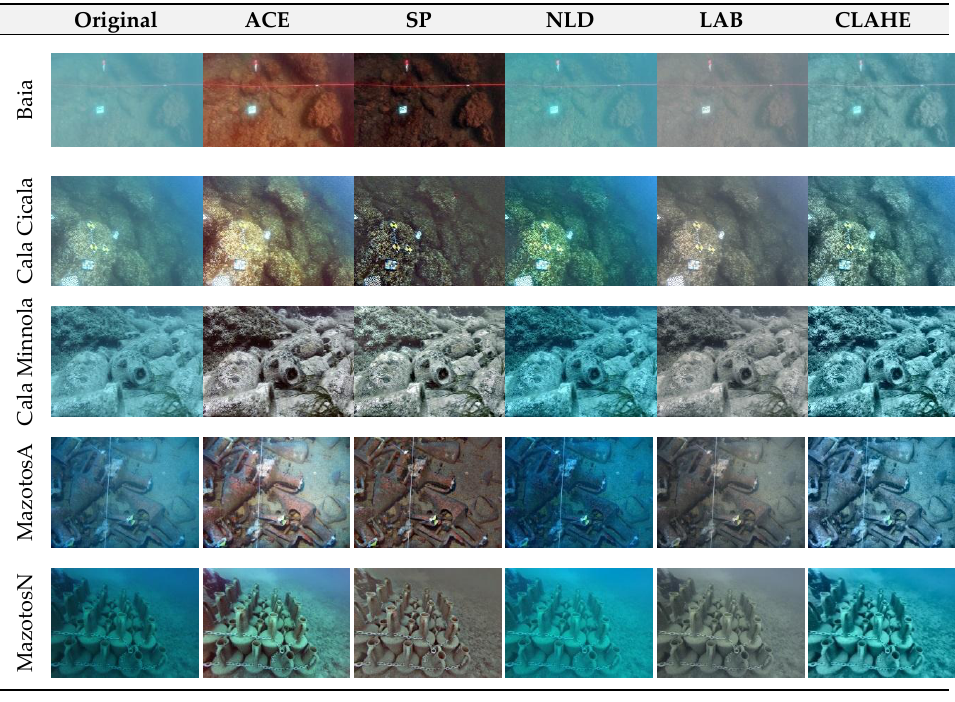
Figure 5. Examples of original and corrected images of the 5 different datasets. Credits: MiBACT-ISCR (Baiae images); Soprintendenza Belle Arti e Paesaggio per le province di CS, CZ, KR and University of Calabria (Cala Cicala images); Soprintendenza del Mare and University of Calabria (Cala Minnola images); MARELab, University of Cyprus (MazotosA images); Department of Fisheries and Marine Research of Cyprus (MazotosN